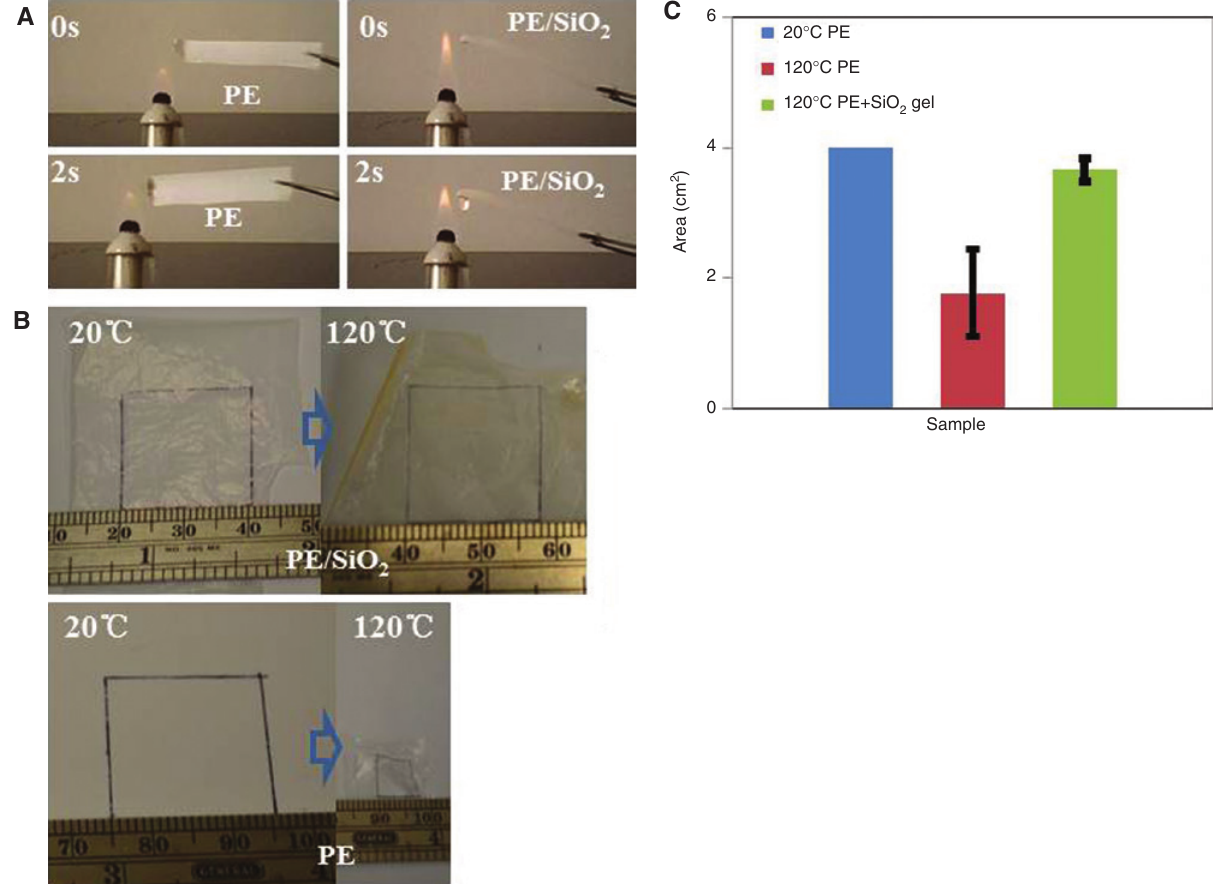
gel composites: (A) comparison of close-to-flame reactions; (B) and (C) area 2